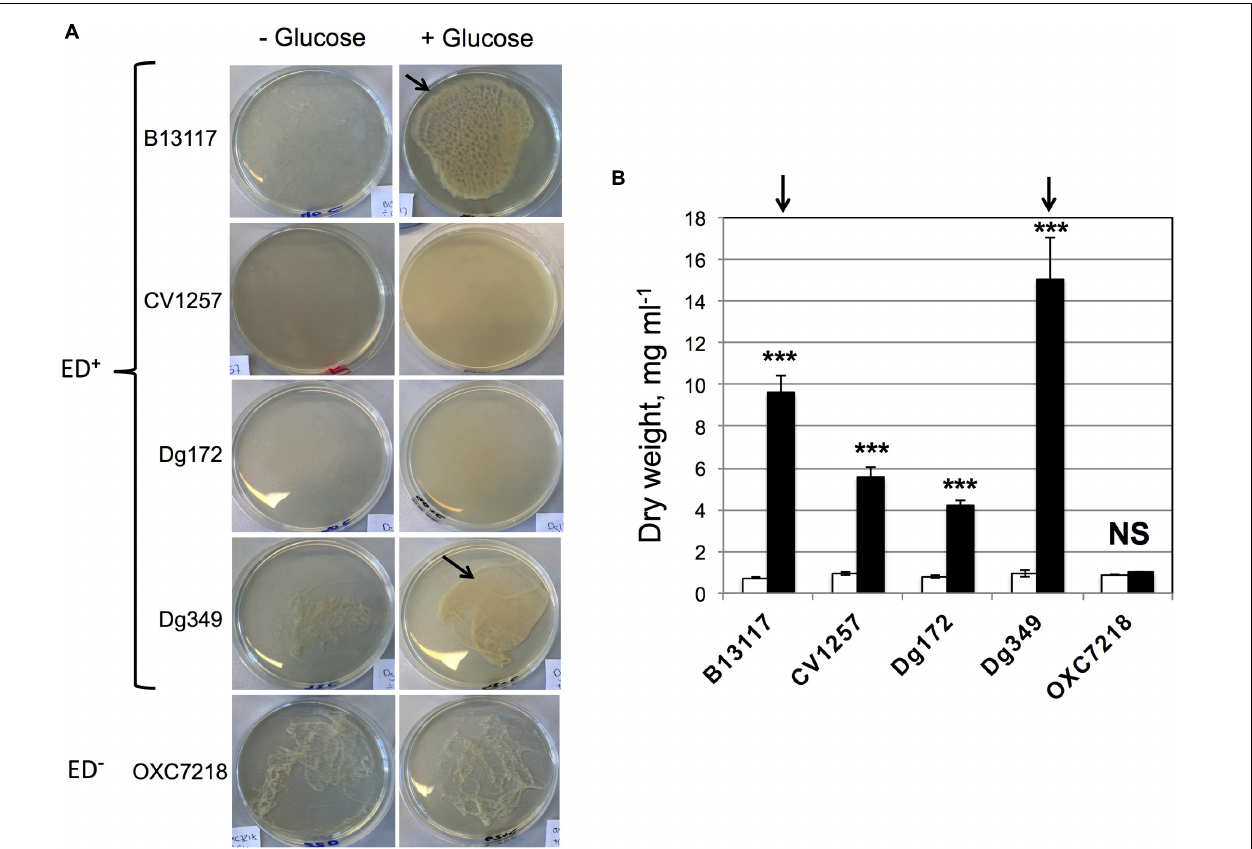
FIGURE 6 | Glucose stimulates production of floating biofilm that increases cell biomass. (A) The isolates of C. coli shown were cultivated for 4 days at 37 ◦ C under microaerobic conditions in glucose-free TSB with and without supplementation with 100 mM glucose. The glucose-supplemented cultures of B13117 (ED + ) and Dg349 (ED + ) formed extensive floating biofilm (flocs; arrowed ). CV1257 (ED + ) and Dg172 (ED + ) displayed denser growth with glucose but no biofilm formation, while a low level of aggregation was seen in the cultures of ED-negative OXC7218 regardless of glucose-supplementation. Pictures are representative cultures from four independent growths. (B) The four ED-positive C. coli isolates (B13117, CV1257, Dg172, and Dg349) and the ED-negative C. coli strain OXC7218 were cultivated for 7 days at 37 ◦ C under microaerobic conditions in glucose-free TSB with or without glucose supplementation. The bars show dry weight biomass of 5 ml aliquots from cultures without glucose (white bars) and with glucose supplementation (black bars). The mean and standard deviations of four independent cultures for each condition are shown. The statistical significance of the difference between the dry weight without glucose and with added glucose was evaluated by Student’s t -test, as indicated by ( ∗∗∗ p < 0.001) or NS (not significant). The arrows refer to the biofilm producing strains B13117 and Dg349 as in (A) , which clearly produce more biomass with glucose compared to the other non-biofilm producing strains